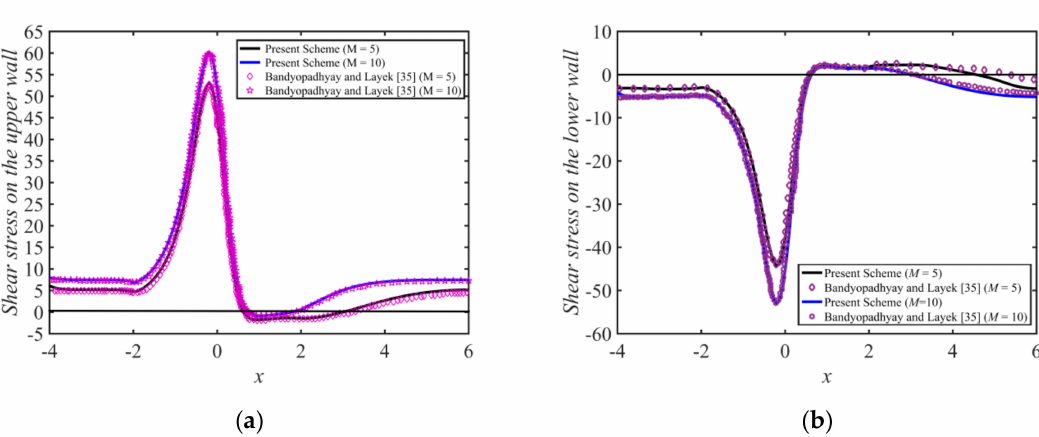
Figure 2. Wall shear stress distributions for the pulsatile flow, for M = 5, 10, at Re = 700, h 1 = h 2 = 0.35, st = 0.02, and t = 0.25: ( a ) on the lower wall, and ( b ) on the upper